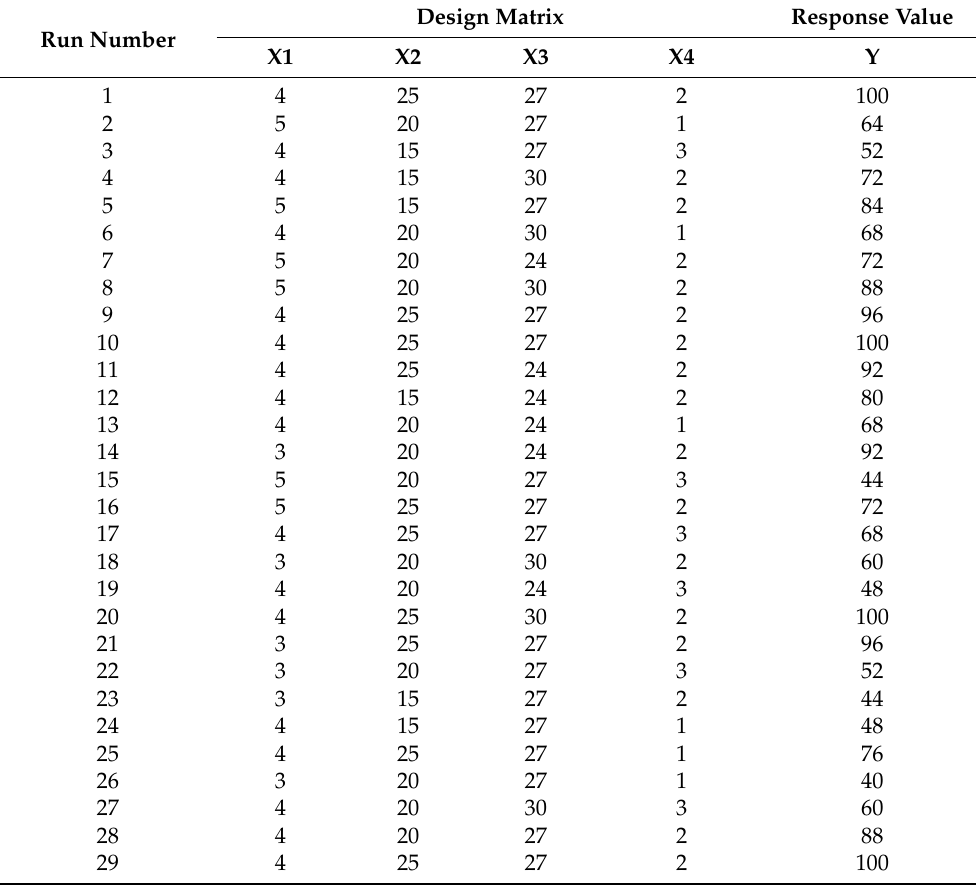
Table 6. Experimental design and simulation results of the response. Run